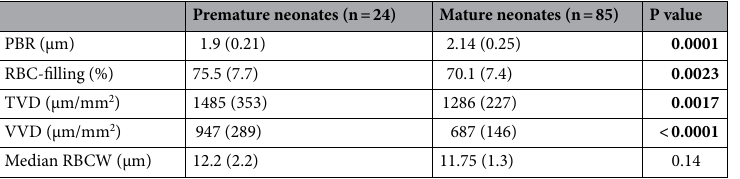
Table 3. Microcirculatory parameters of premature and mature neonates obtained at 36-72 h of life. Data are presented as mean (SD). For VVD and TVD values of one preterm infant are missing due to technical problems during measurement. Statistical analysis was performed with t test. Statistically significant results are marked in